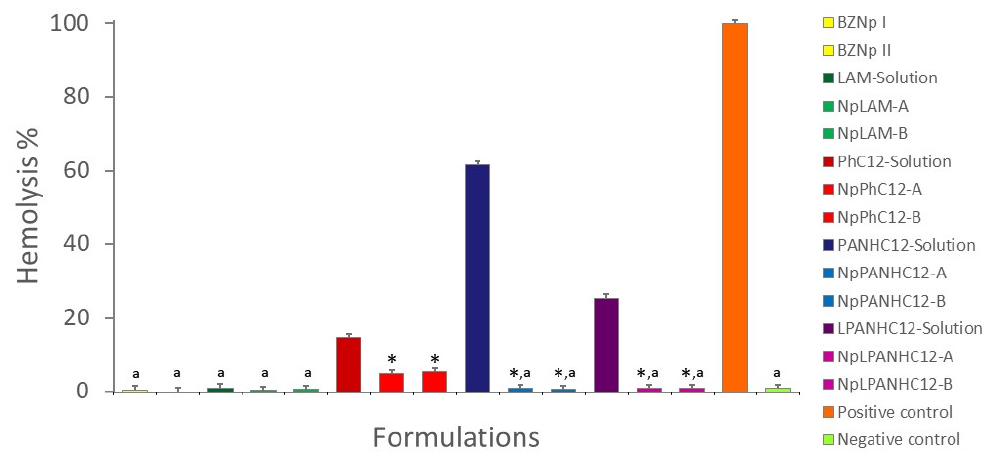
Figure 13. Hemolytic activity of the surfactants´ solutions (35.6 µg/mL) and loaded-zein nanoparticles prepared by method A and B. The results are expressed as percentage using the positive control as reference. Negative control was PBS 7.4 solution and positive control was ultrapure water. * Significatively reduced the hemolytic activity compared to the respective solution ( p < 0.05). ᵃ Equal to the negative control ( p > 0.05). Data submitted in pairs to one-way ANOVA with post hoc Tukey test when p < 0.05.